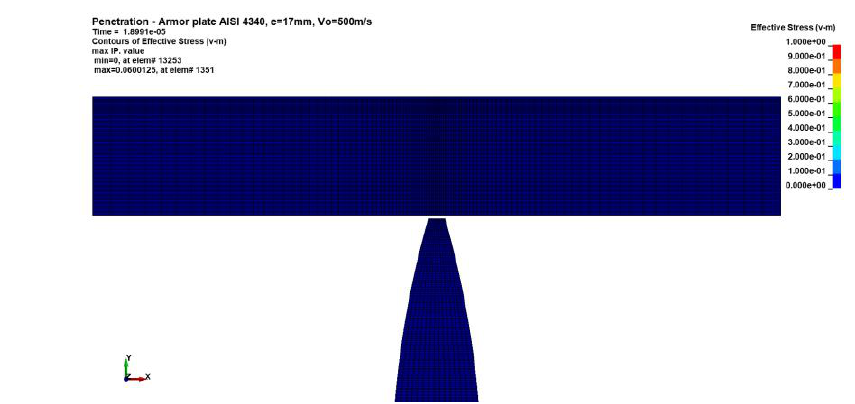
Figure 17 – Von Misses equivalent stress, time of analysis 0.01 ms – Model 3 Рис. 17 – Von Misses эквивалентное напряжение, время анализа 0.01 ms – Модель 3 Слика 17 – Von Misses-ов еквивалентни напон, време анализе 0,01 ms – модел